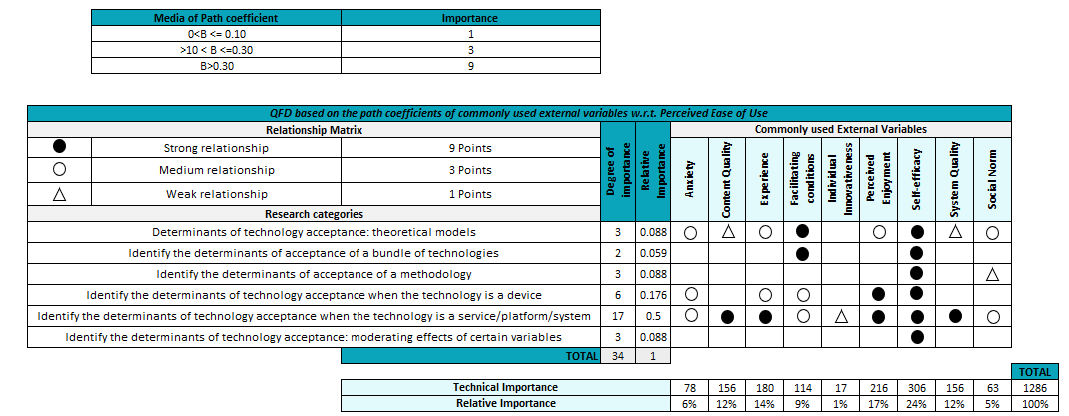
Figure 6. Quality Function Deployment (QFD) matrix for Perceived Usefulness.